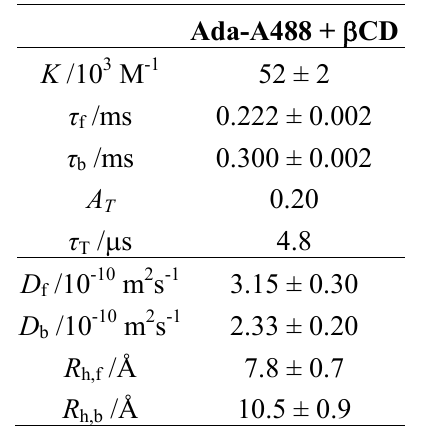
Table 1. Results of the global target fit of Equations (9) and (10) to the correlation curves shown in Figure 4 and calculated values. All values at 25.0 ± 0.5